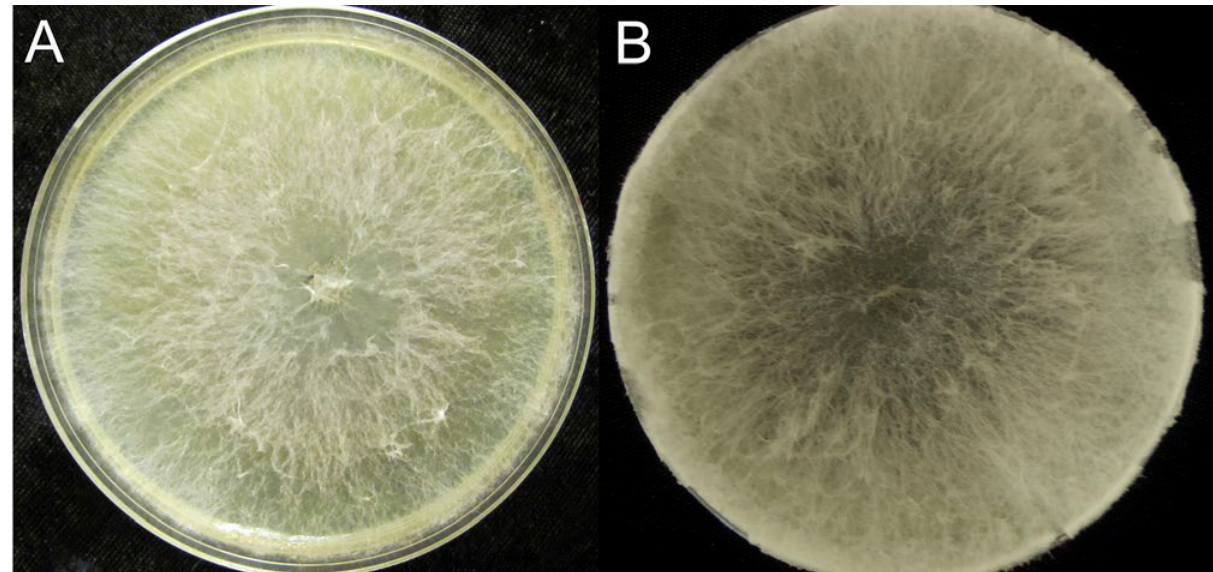
Figure 2. Neofusicoccum luteum strain UCR1190 (a) yellow pigment on a 3 d old Petri plate culture, (b) darkened 12 d old